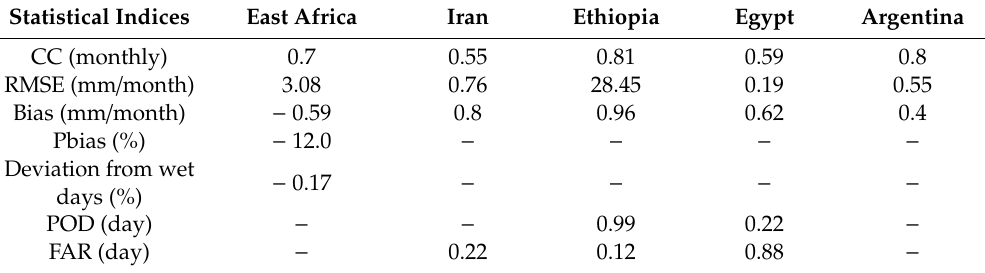
Table 10. Summary of previous studies findings on CHIRPS performance in areas similar to Yemen’s